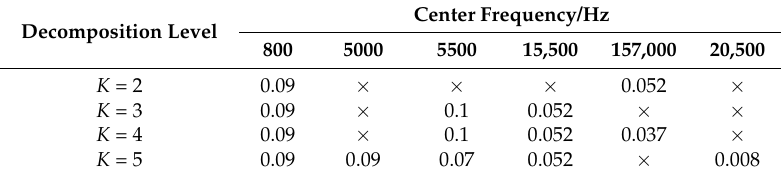
Table 2. Decomposition results under different K values. The × means nothing in Table 2.